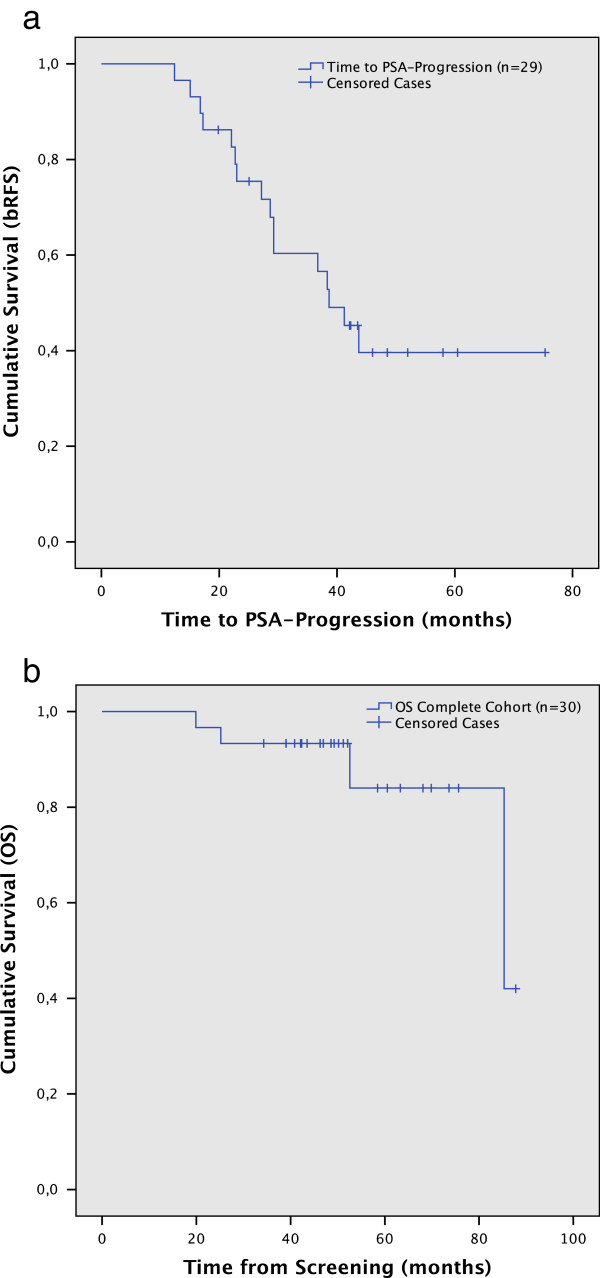
Kaplan–Meier plot for a. biochemical recurrence free survival (bRFS), in patients defined as therapy responders (n = 29). b. overall survival (OS) in the complete cohort of patients.